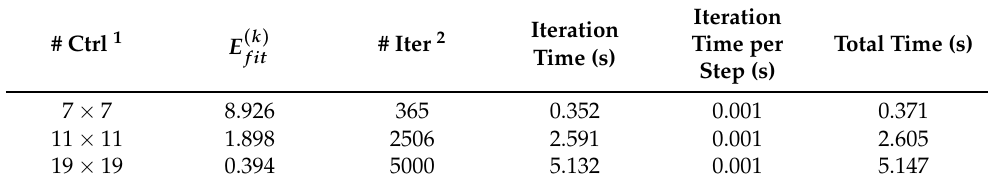
Figure 4. Comparison of the absolute error between the numerical and analytical solutions after each knot refinement. ( a ) Analytical solution. ( b ) n = 7 × 7, absolute error = 1.200. ( c ) n = 11 × 11, absolute error = 0.115. ( d ) n = 19 × 19, absolute error = 0.052. Table 2. Experimental data of Incre-IG-LSPIA algorithm with twice knot refinement. The number of collocation points is m = 31 ×